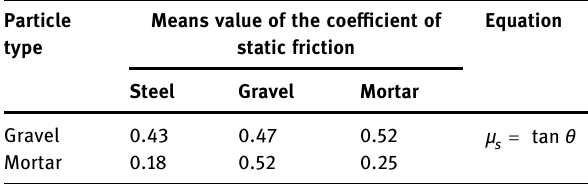
Table 4: Coe ffi cient of static friction of gravel and mortar Particle type